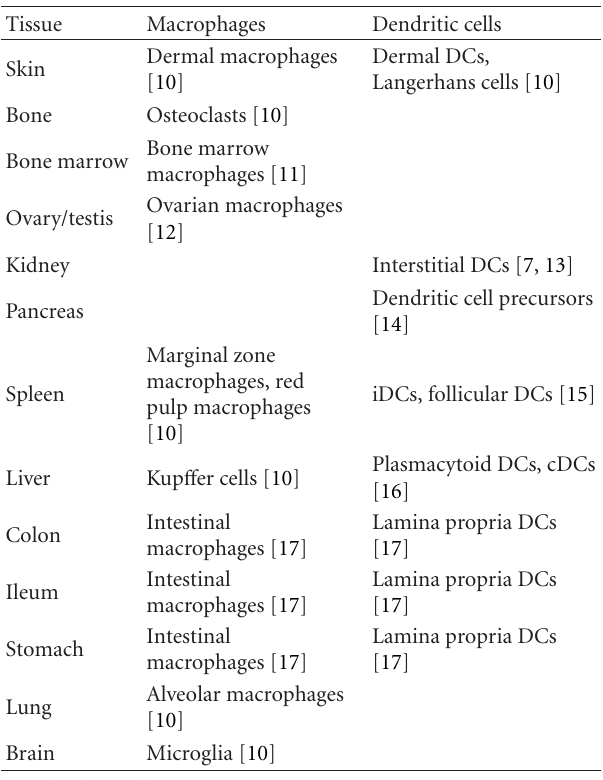
Table 1: Resident mononuclear phagocytes in various organs and